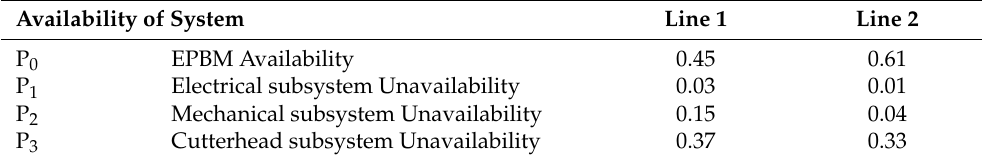
Table 10. Availability of EPBM in Lines 1 and 2.